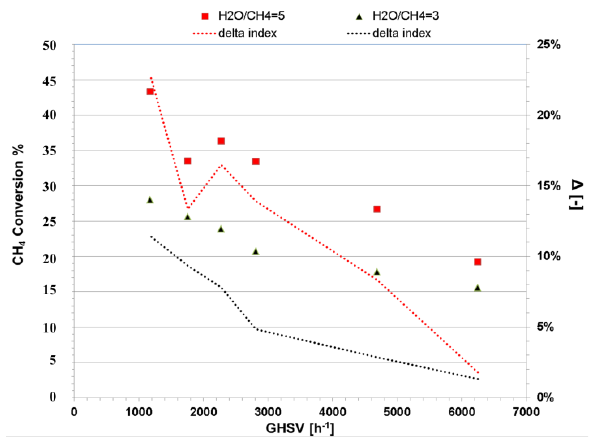
Figure 9. Experimental methane conversion of the dual catalyst CMR represented as scatter points and the difference between CMR and PBR at 5 bar, at a temperature of 475 °C. the difference between CMR and PBR at 5 bar, at a temperature of 475